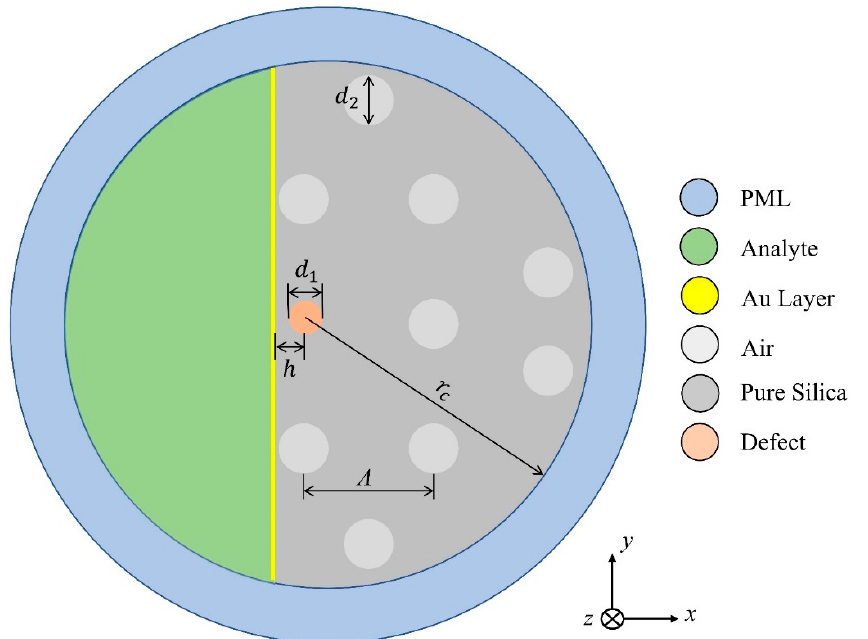
Figure 1. Cross section sensor design.